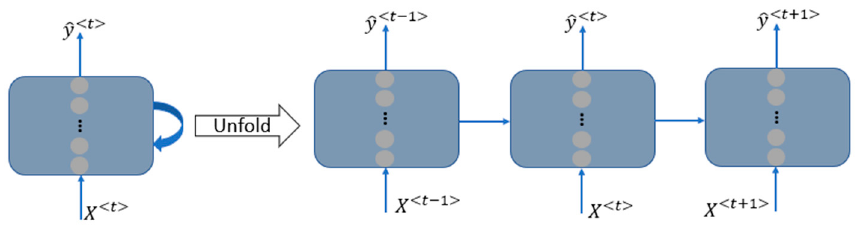
Figure 1. Recurrent neural network (RNN) architecture: recurrent layer with a feedback loop, indicating the additional time dimension after unfolding